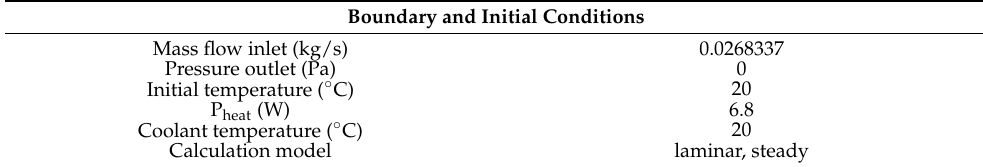
Table 3. Boundary and Initial Conditions.